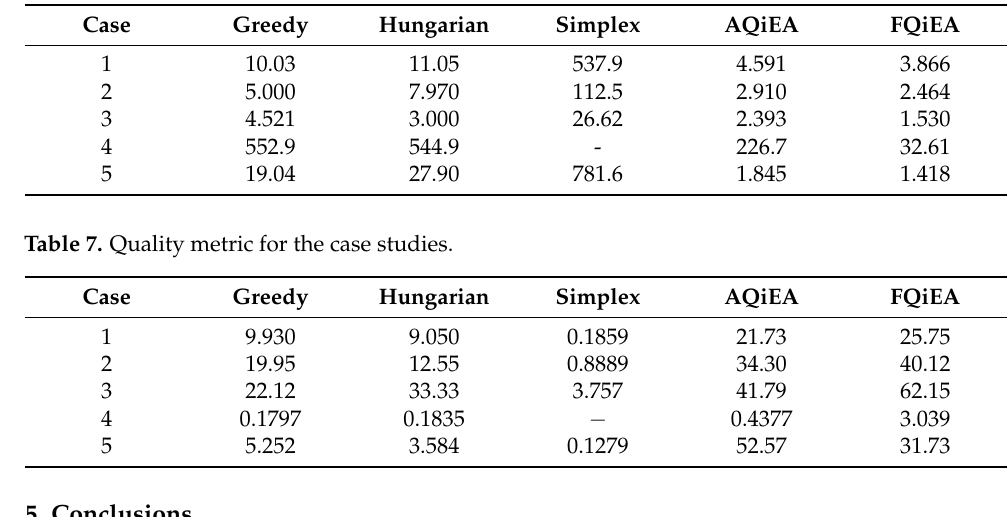
Table 6. Execution time in ms for the case studies.